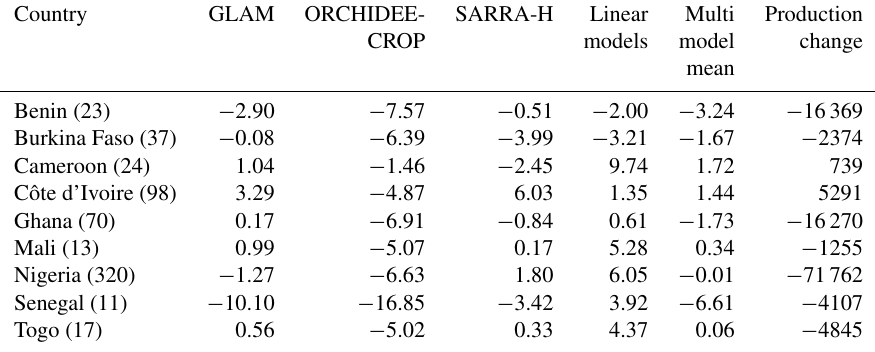
Table 6. Percentage maize yield change by country. The number of grid cell analysed is in brackets and countries where fewer than 10 grid cells were analysed have been omitted. The production change is shown in the rightmost column in tonnes. Country